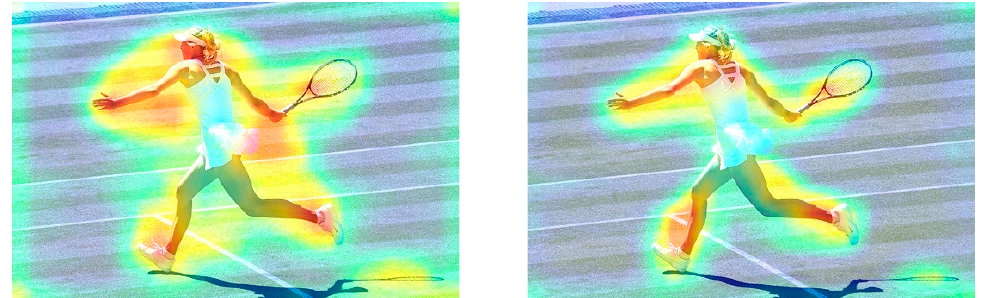
Figure 2. Visualization of the attention heatmap obtained from different distillation methods: utilizing ( left ) only the coordinate knowledge during distillation and ( right ) both coordinate knowledge and inferior knowledge.